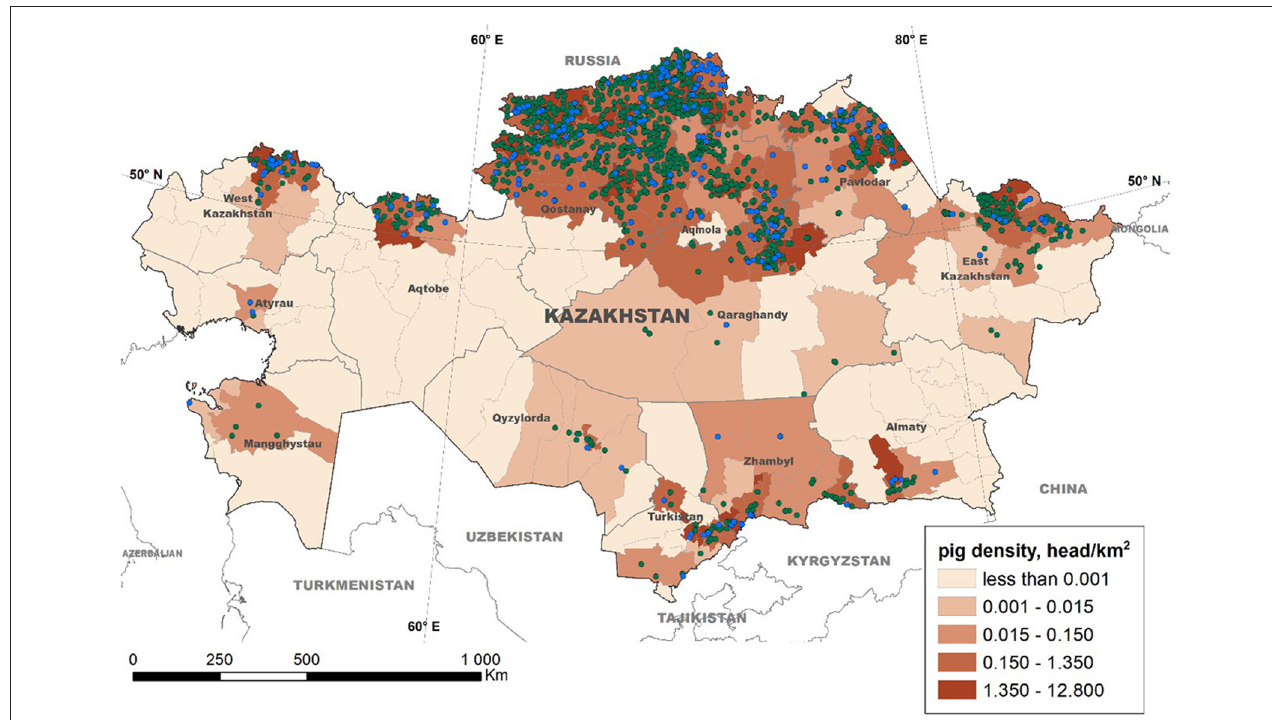
FIGURE 2 | Distribution of swine farms in Kazakhstan. The location of swine operations is indicated and categorized as single-owner farms (green dots) and commercial association-owned (blue dots) farms. The color gradient denotes the pig density (head/sq km) estimated at the district level.